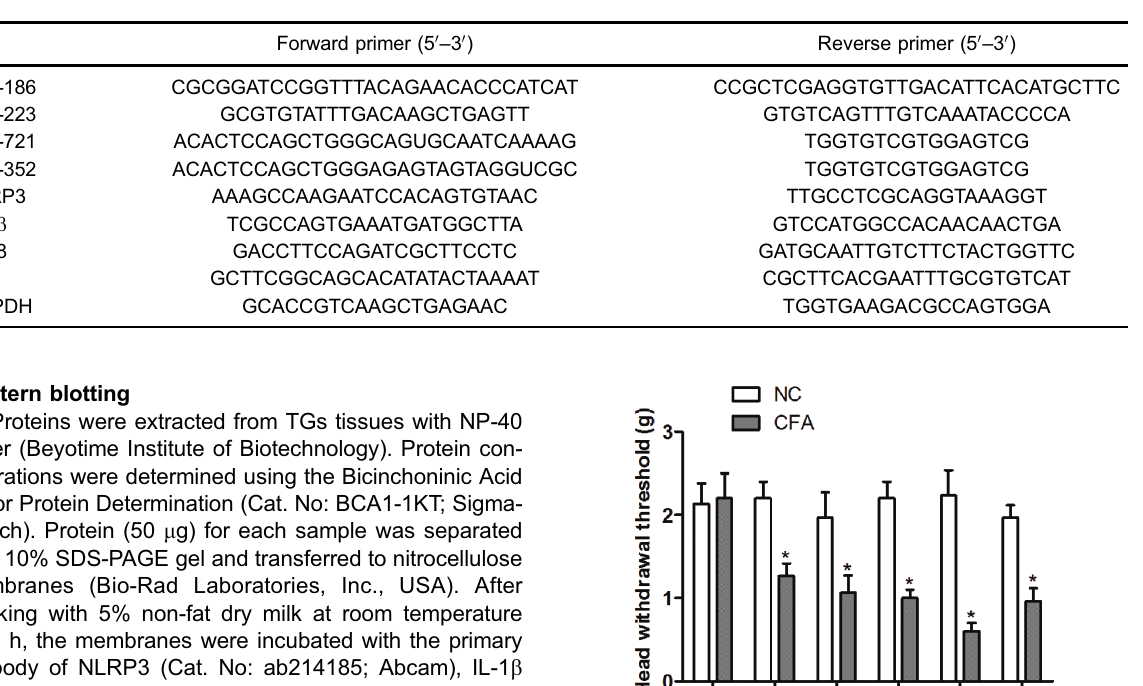
Table 1. miRs and mRNA primers.